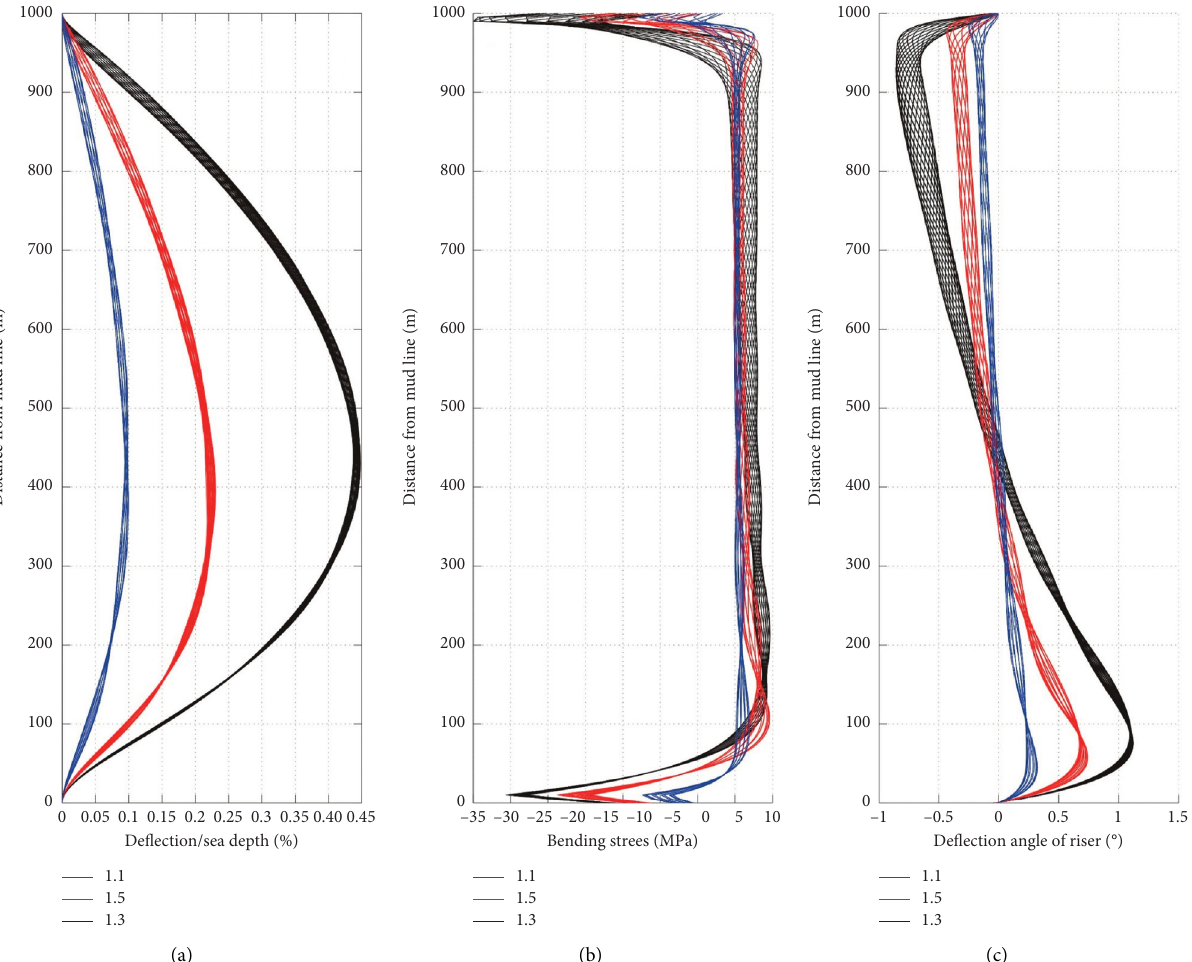
Figure 8: Comparison of dynamic responses for risers with different buoyant factors, (a) distribution of lateral deflection, (b) distribution of bending stress, and (c) distribution of deflection angle of the